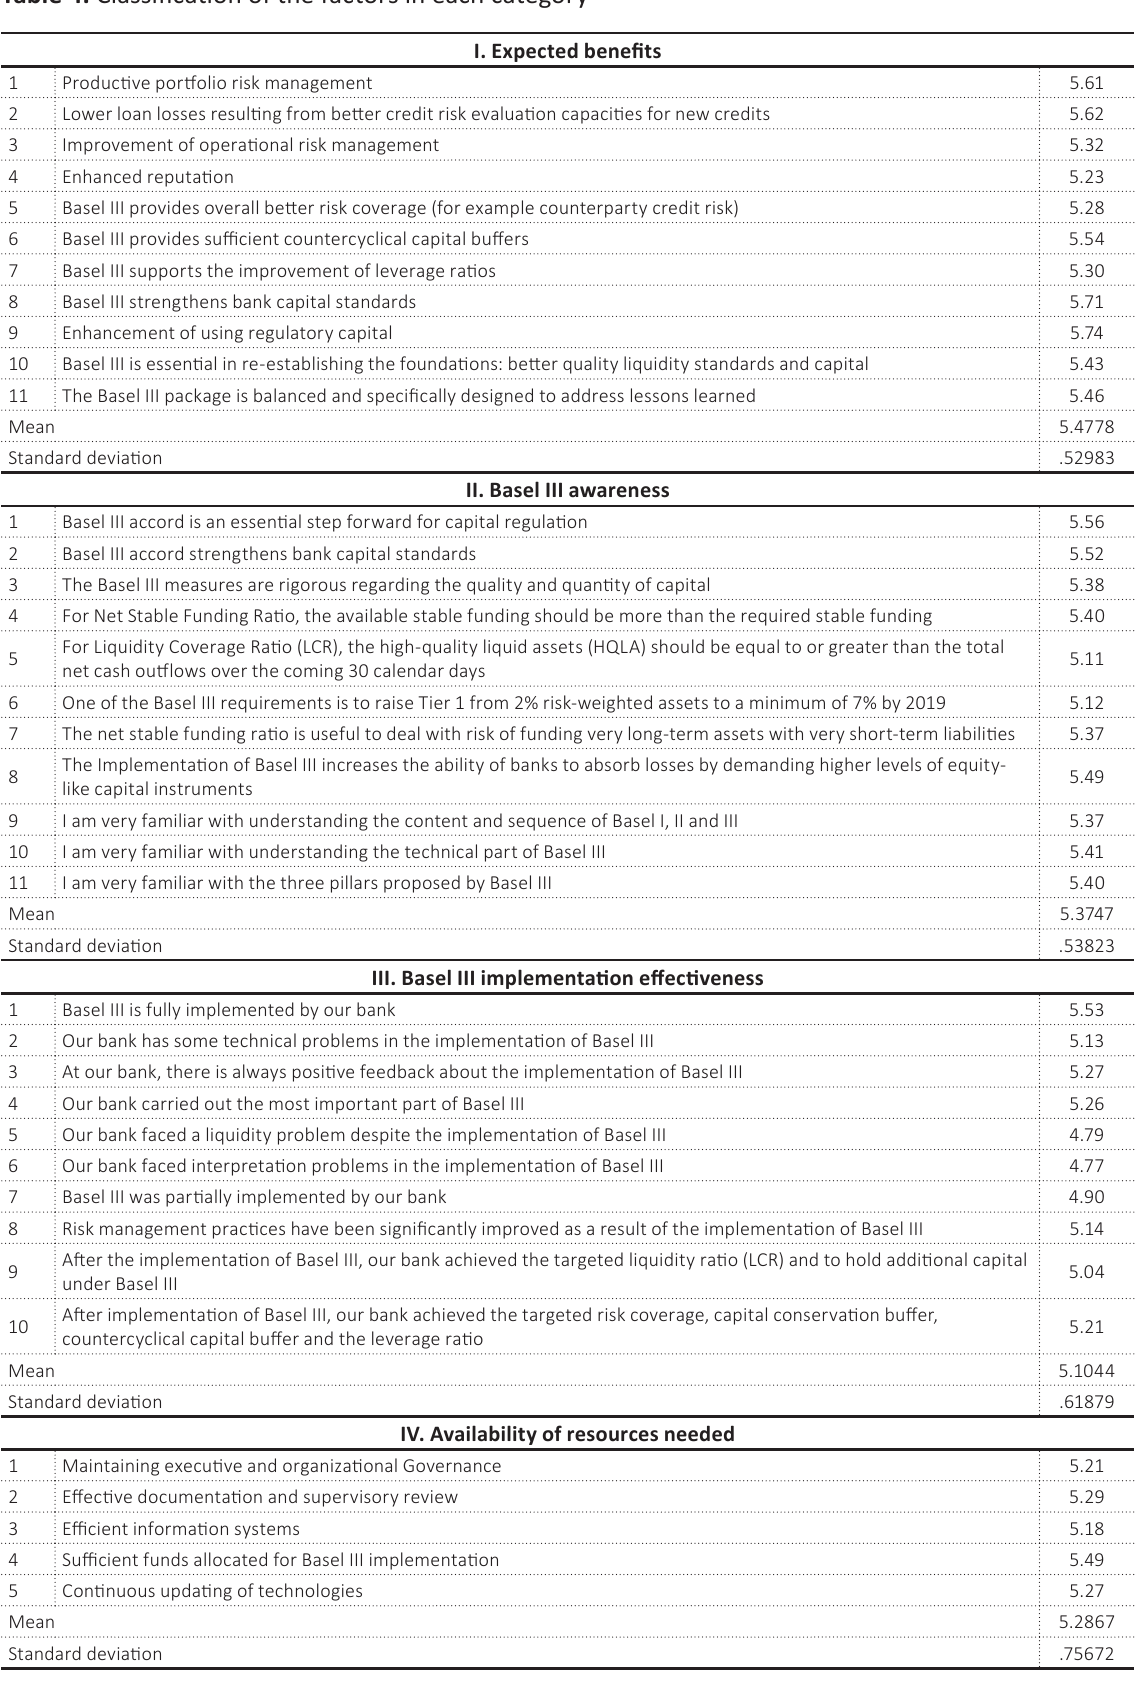
Table 4. Classification of the factors in each